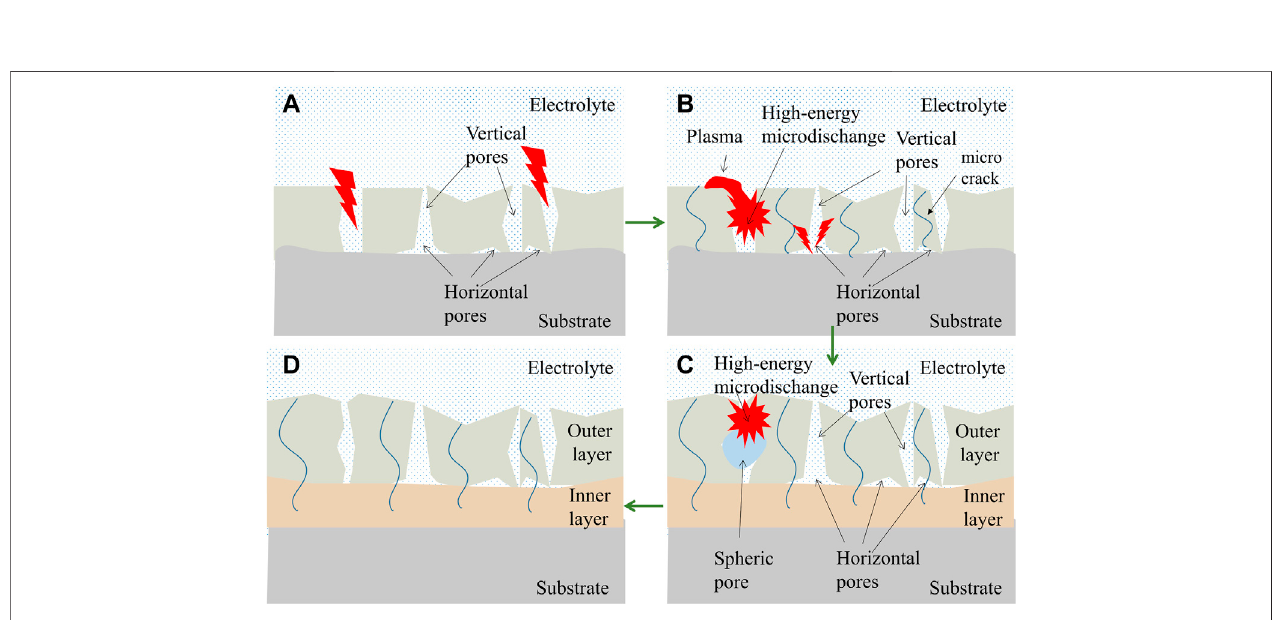
FIGURE 9 | Formation mechanism of the MAO fi